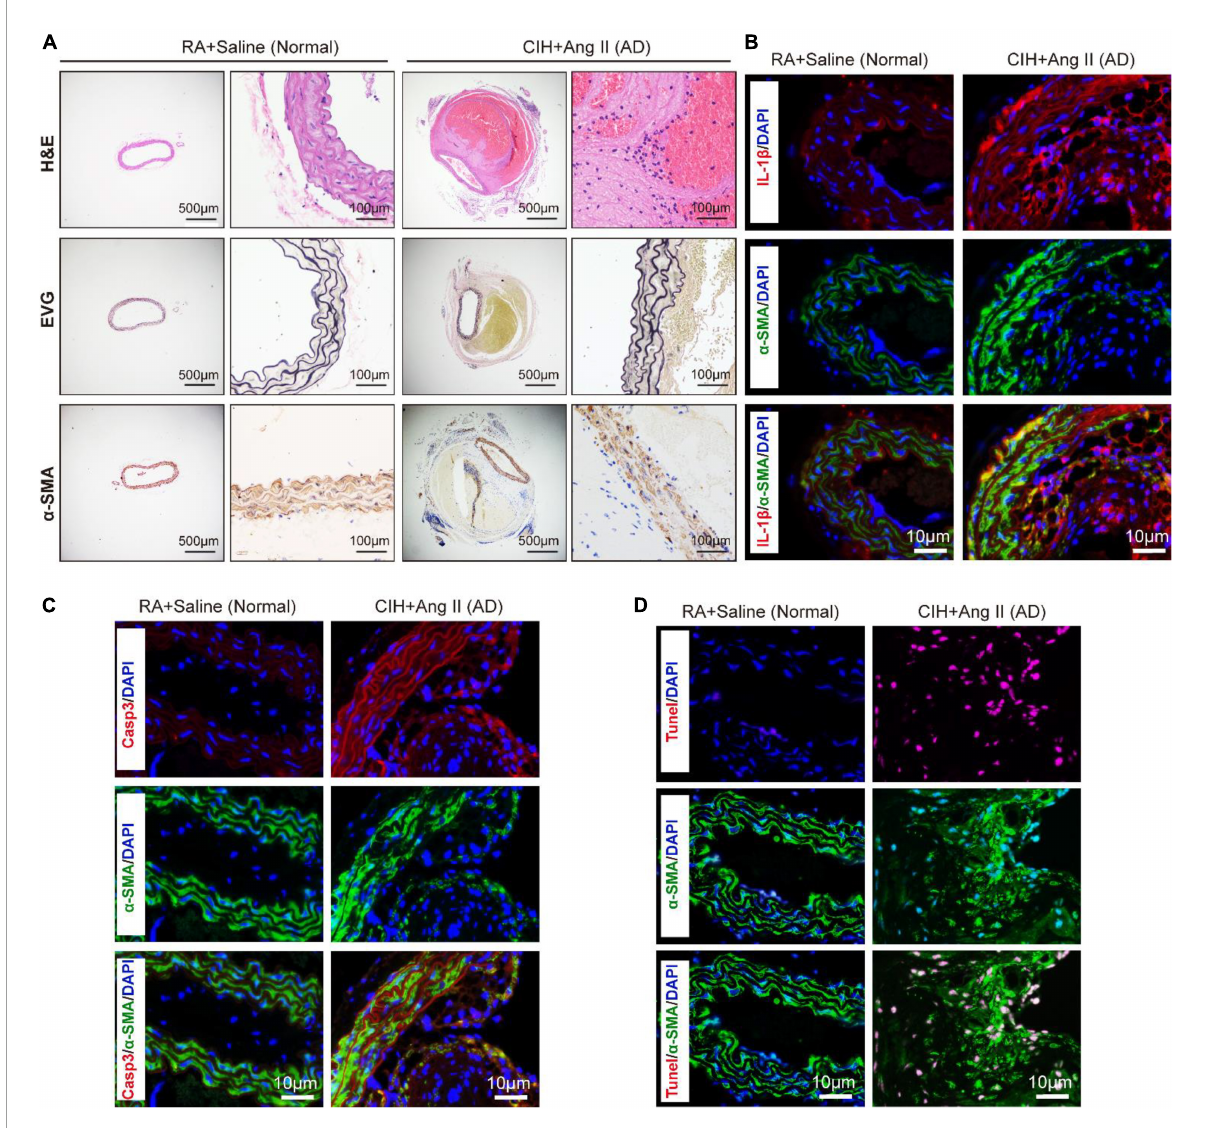
FIGURE2 Transverse section of pathological aortic tissues. (A) Representative images exhibit aortic sections stained with H&E (first row) and EVG (second row). The third row shows aortic sections stained with the α -SMA antibody. (B–D) Representative images of immunofluorescence